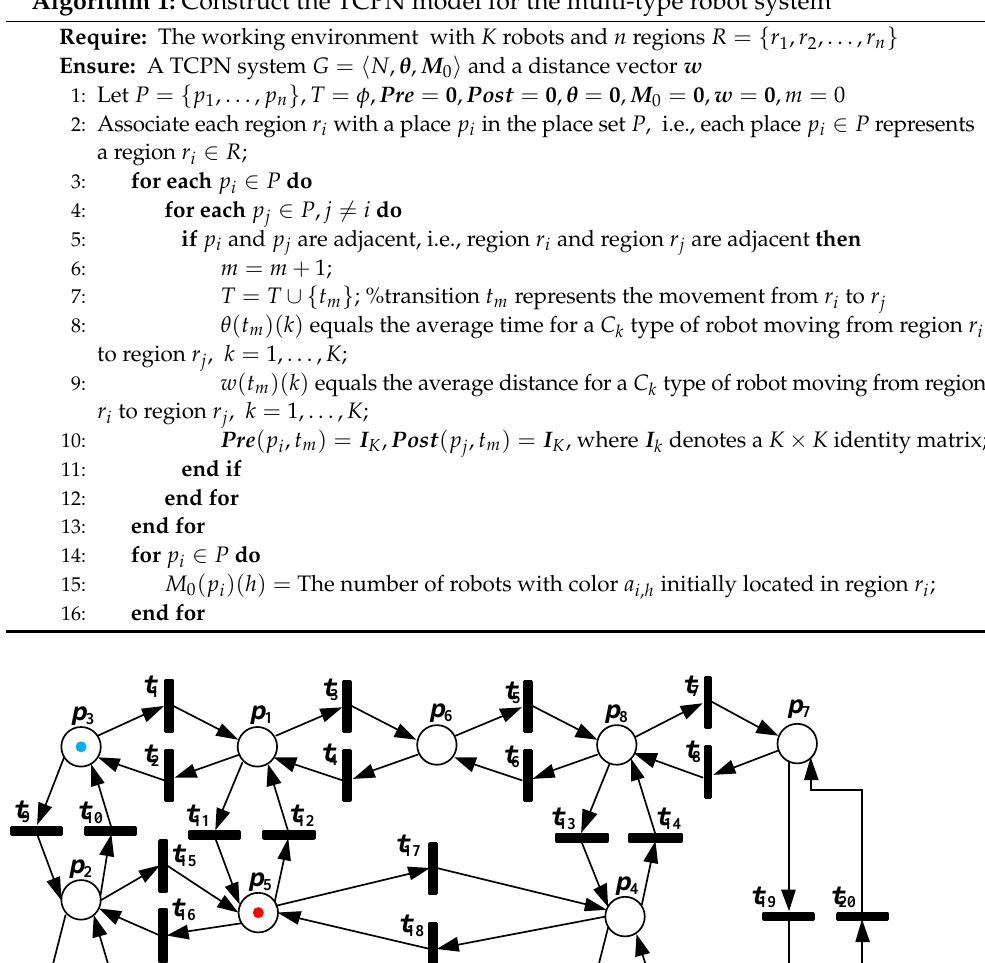
Algorithm 1: Construct the TCPN model for the multi-type robot system